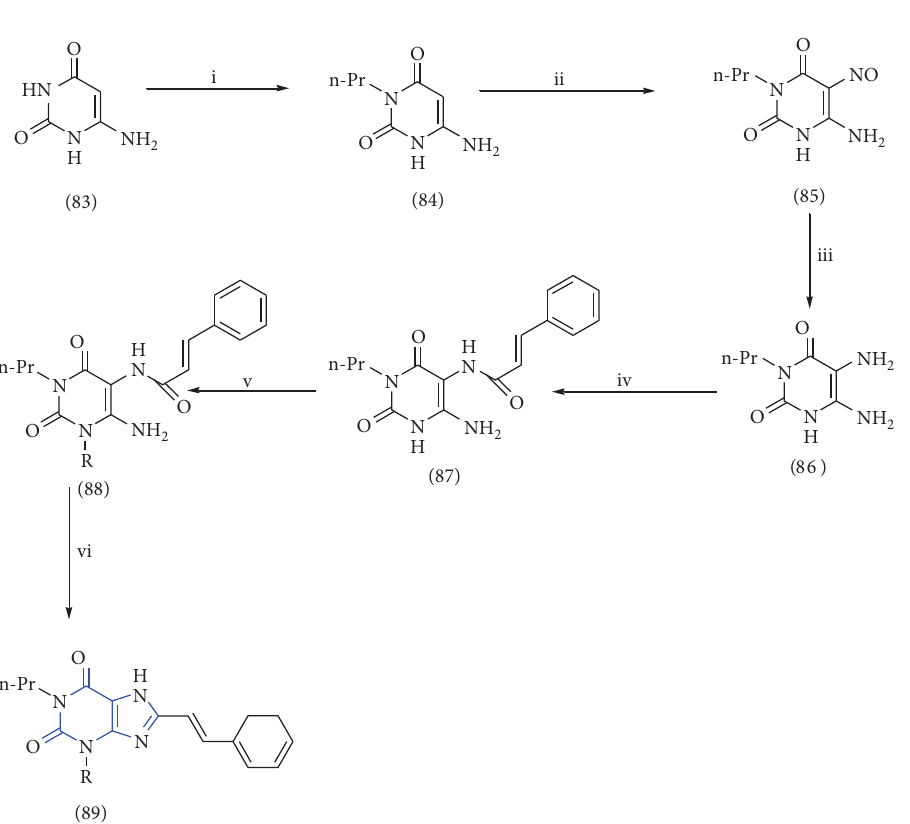
Scheme 13: 1,3-disubstituted